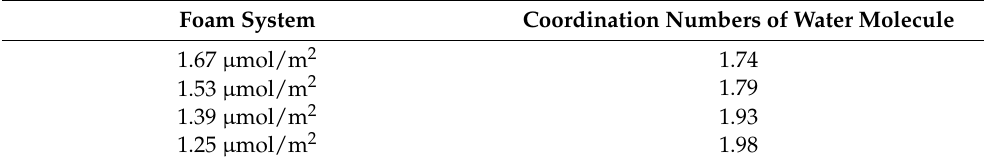
Table 4. Coordination numbers of water molecules in the hydration shells of foam systems with different SDBS